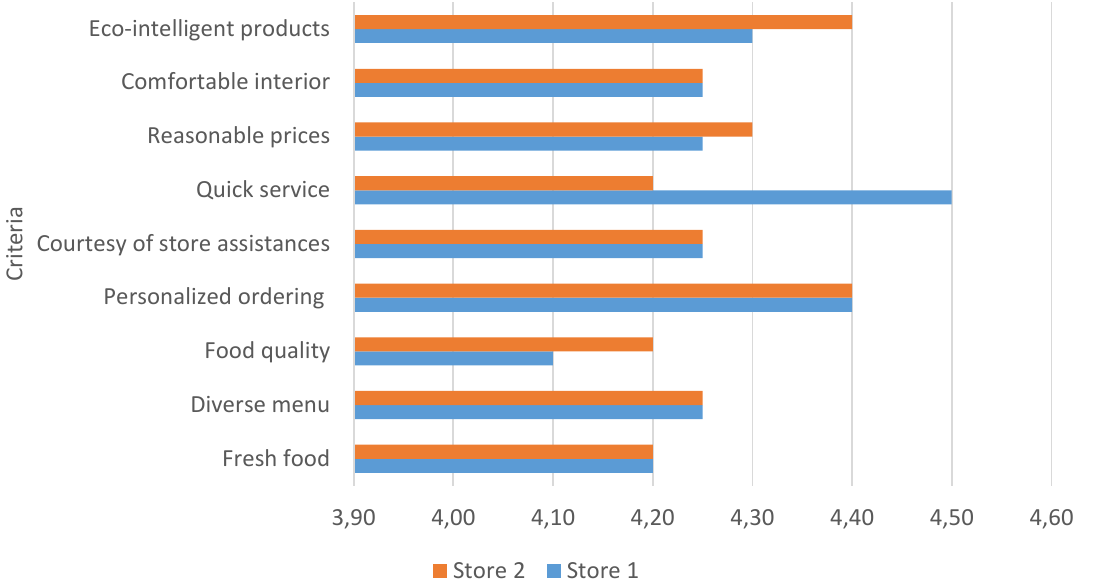
Figure 2. Service evaluation by customers: five-point